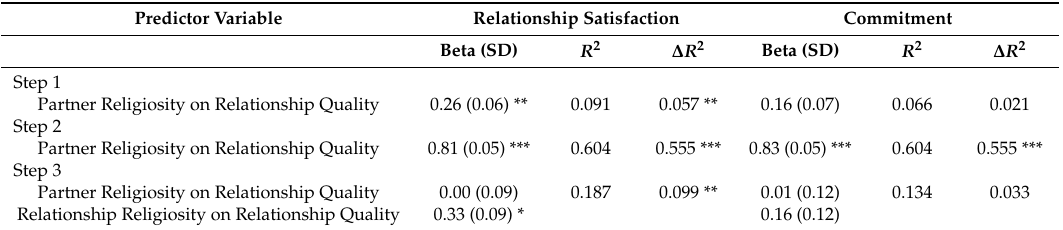
Table 4. Mediation analyses for partner religiosity for relationship quality ( N =